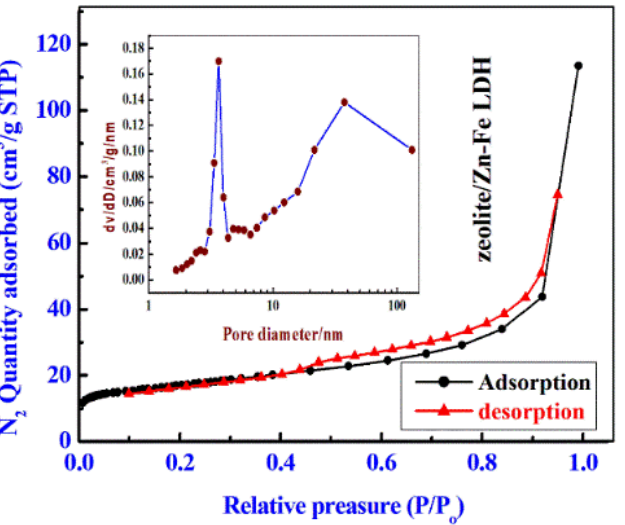
Figure 6. N 2 adsorption/desorption isotherms zeolite/Zn-Fe LDH nanocomposite and the inset figure is BJH pore size distributions.